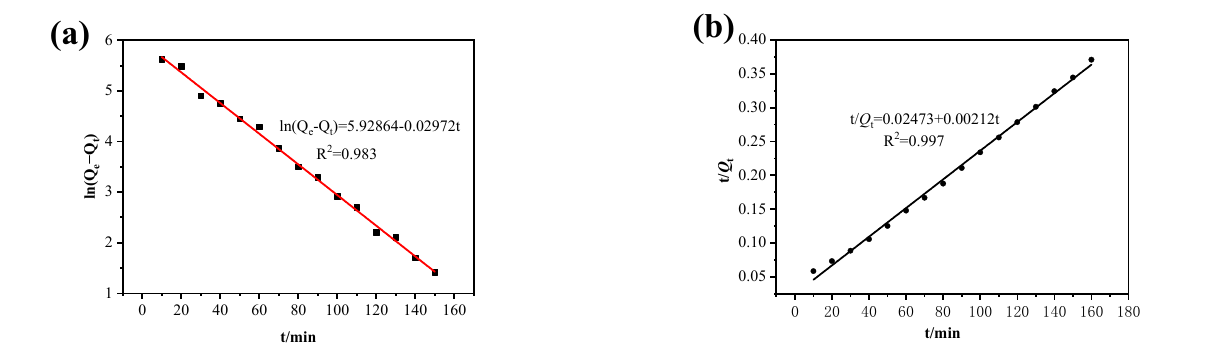
Figure 12. Pseudo-first-order and pseudo-second-order nonlinear fitting of dynamics.